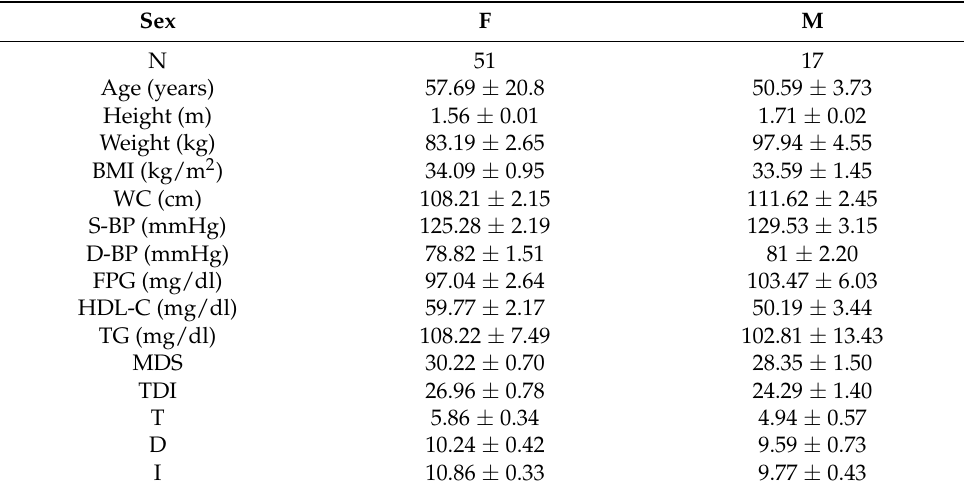
Table 1. Anthropometric, clinical, nutritional, and olfactory characteristics of the whole sample and divided by